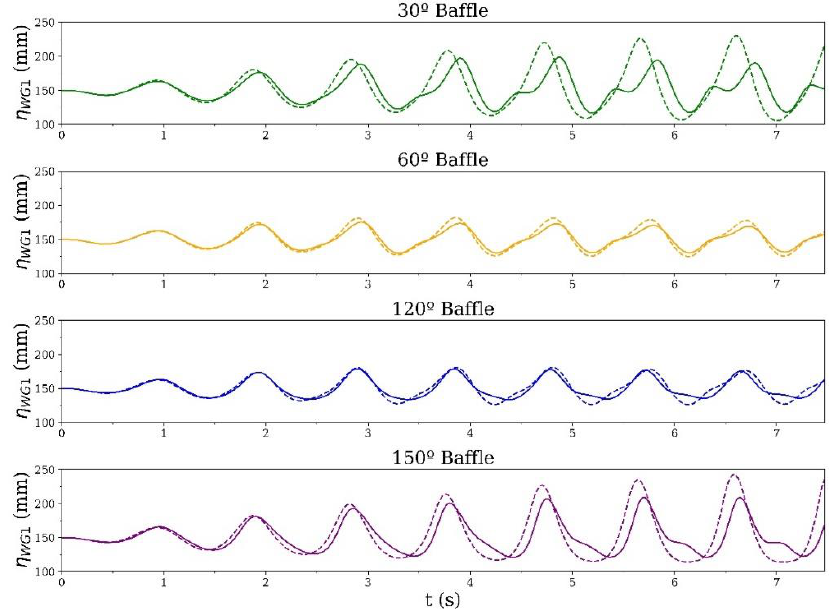
Figure 4. Free surface elevation at WG1. The solid line represents the simulations where H b = 75 mm, the dotted line where L b = 75 mm.